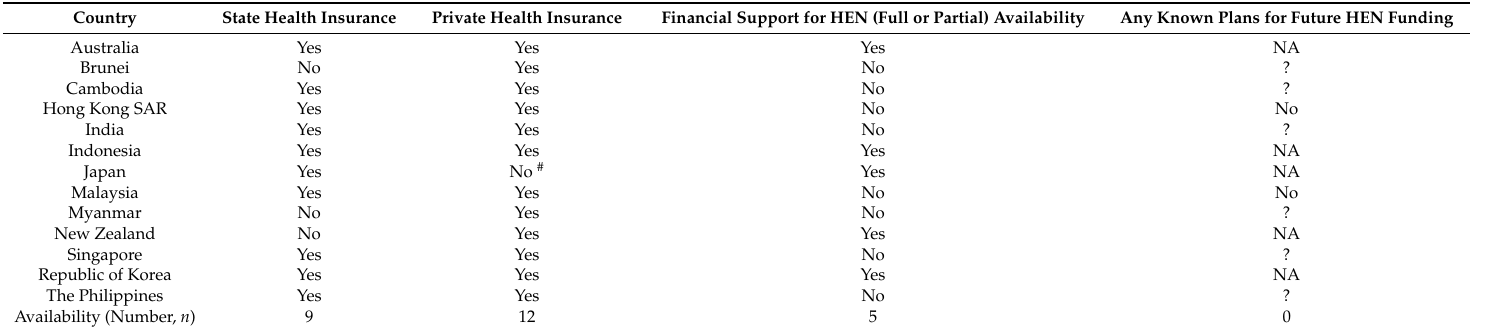
Table 2. Healthcare Financing in Countries Participating in the